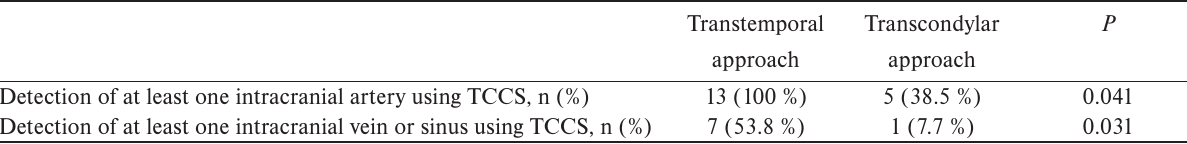
Table 3. Comparison of intracranial vessels detection between transtemporal and transcranial ultrasound